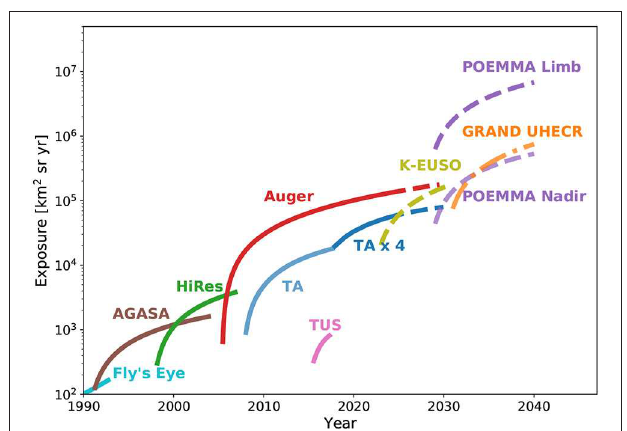
FIGURE 16 | Evolution of the exposure of past, current, and upcoming (solid lines) UHECR experiments as a function of time for ground-based and space experiments. Proposed experiments are also shown (dashed lines). F. Oikonomou and M. Panasyuk for this